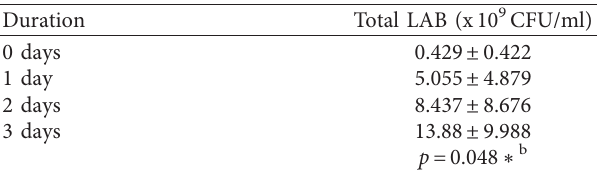
Table 4: Result of total LAB of fermented shrimp sausages at different fermentation times.